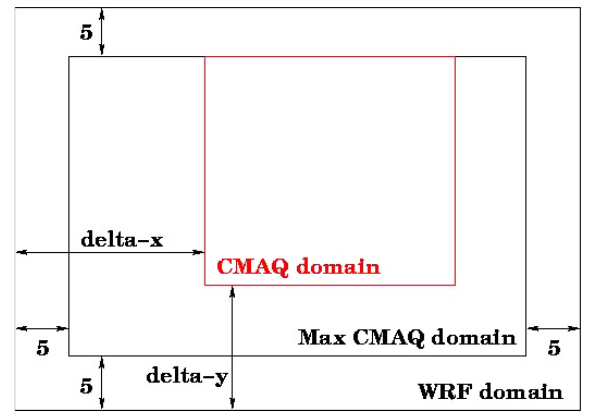
Fig. 2. WRF and CMAQ domain orientation in coupled